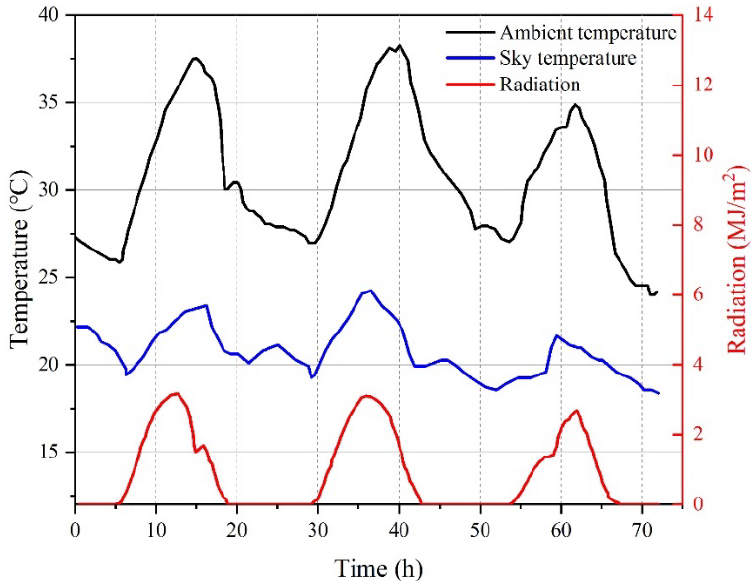
Figure 4. Real-measured ambient temperature and solar radiation curve (15–18 August 2007) [24] .